Question: What style of plot is this figure drawn as?
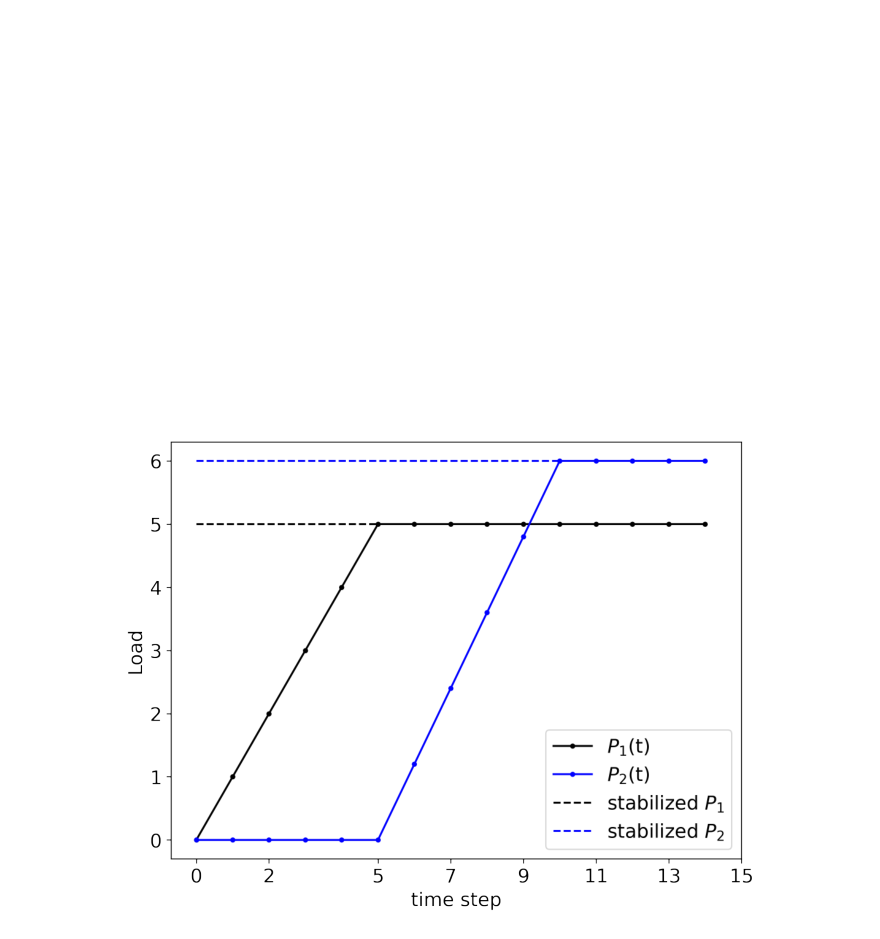
Answer: line